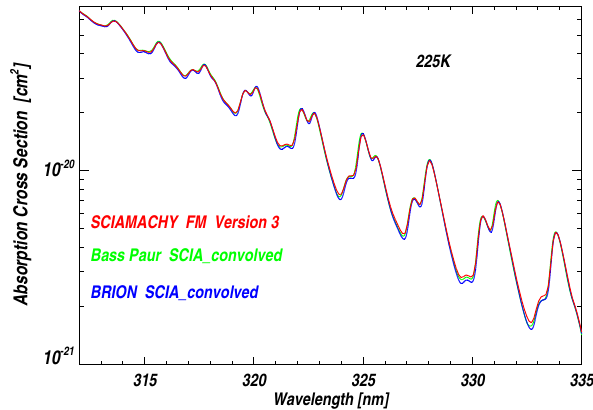
Fig. 1. Comparison between Bogumil et al. (2003) version 3.0 (red), Bass–Paur (green) and Brion (blue) in the Huggins band. The am- plitudes of the absorption structures of the Bogumil et al. (2003) data at the absorption minima are smaller compared to Bass–Paur and